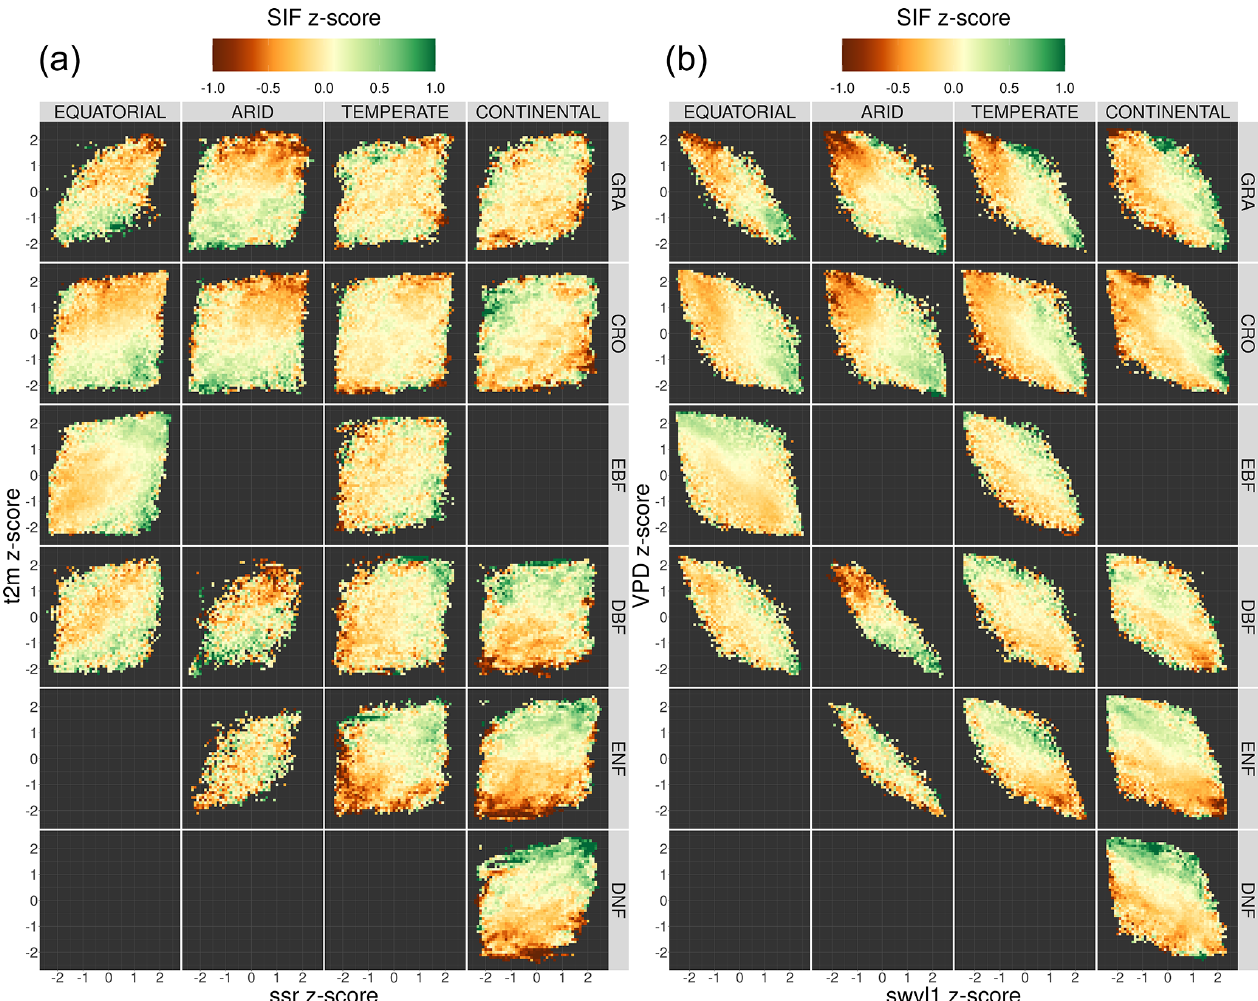
Figure 9. The relationship between fluctuations in meteorological variables and the corresponding fluctuations in the measured downscaled SIF. The fluctuations are measured relative to the monthly mean for each pixel and expressed as a z score. The four meteorological variables are air temperature and net surface solar radiation (t2m and ssr, a ) and vapour pressure deficit and soil moisture (VPD and swvl1, b ). The SIF DS response in each bin is the mean of all data points in each bin of the meteorological z score. The data are broken down into separate Köppen–Geiger climate zones and land cover